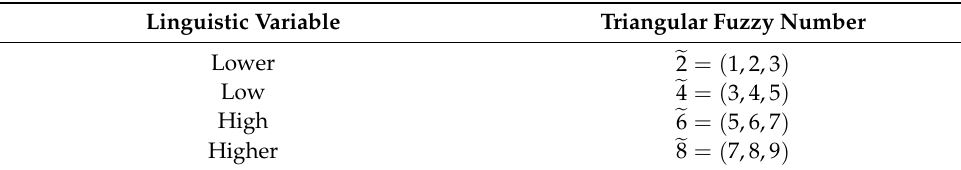
Table 3. The linguistic variables convert to the triangular fuzzy